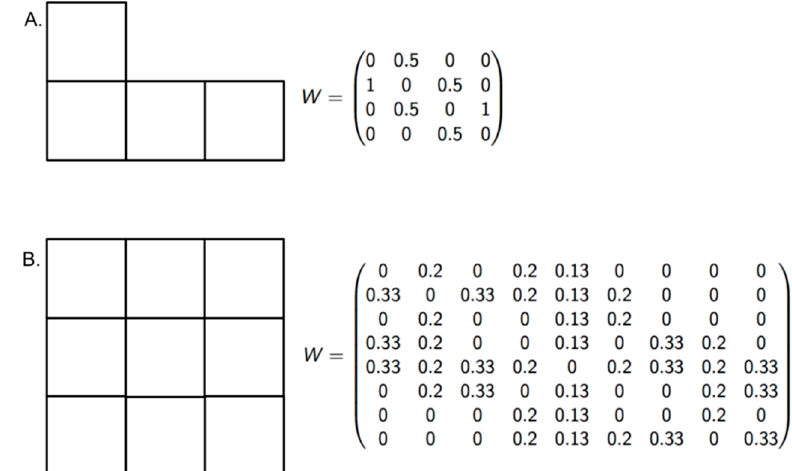
Figure 3. Vicinity configuration and standardized weight matrix. With the aim of validating the modified indices, two block configurations (A and B) were built to propose scenarios with high dengue incidence.